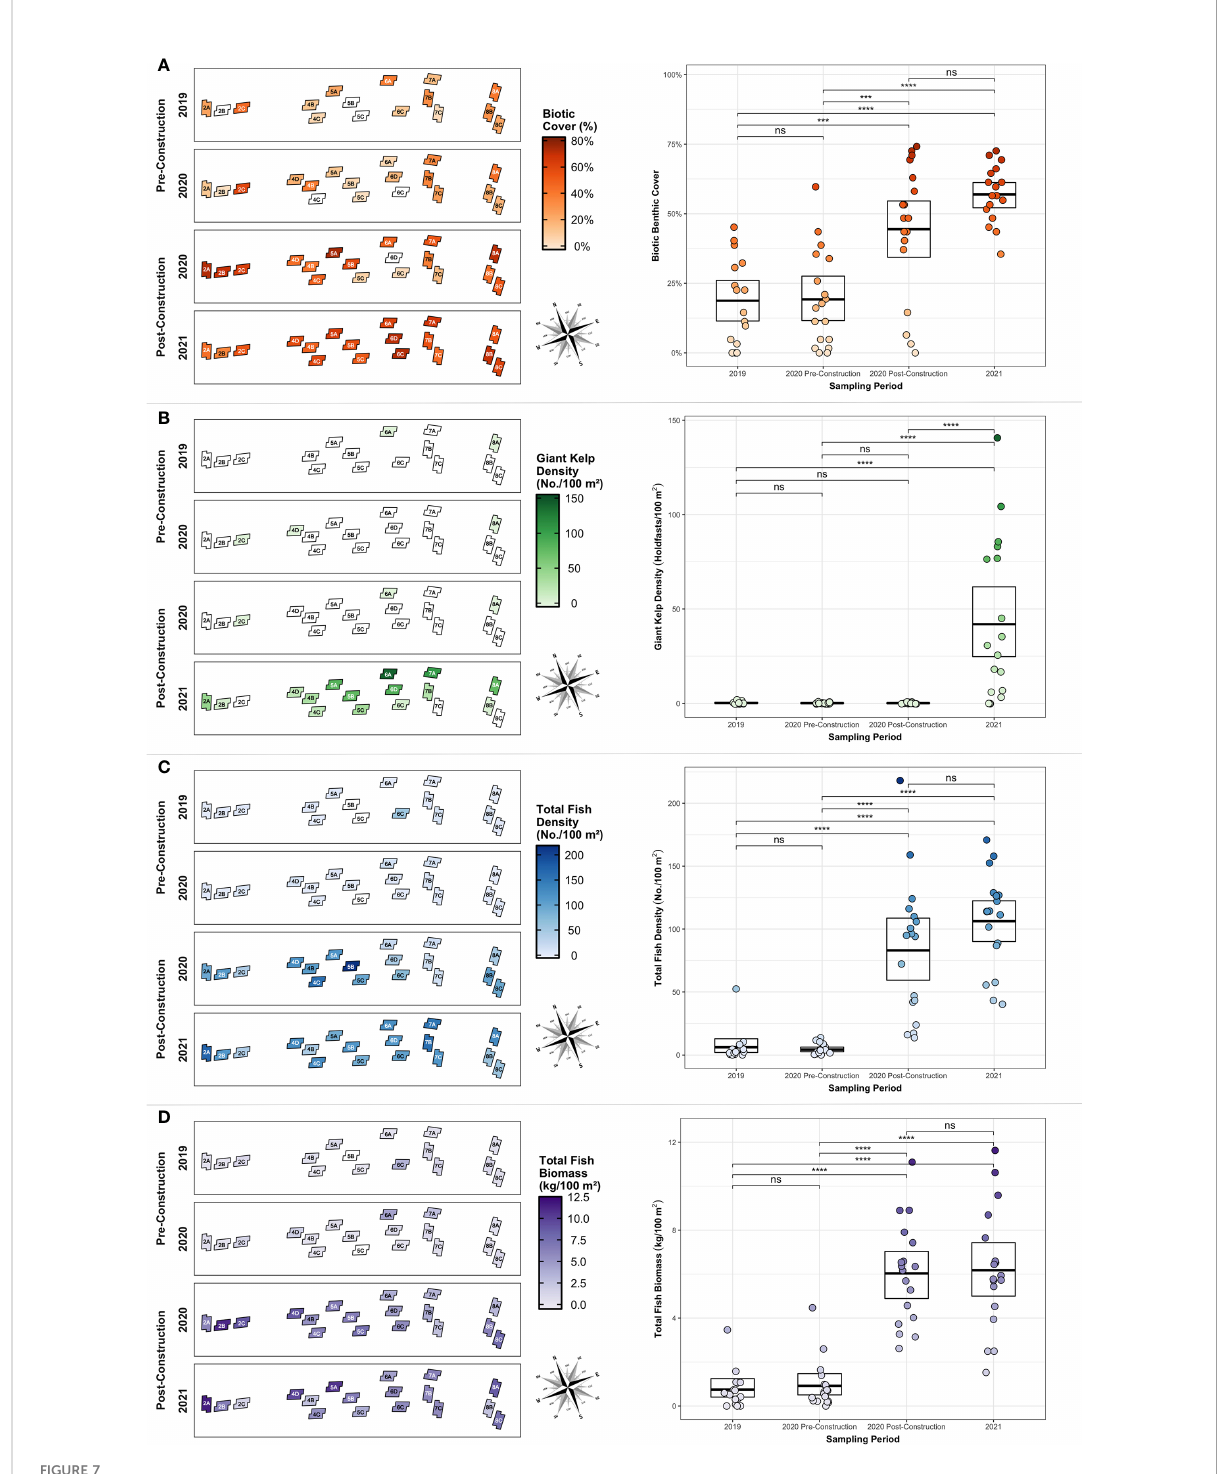
FIGURE 7 (A) Biotic cover, (B) giant kelp holdfast density, (C) total fi sh density, and (D) total fi sh biomass for each sampling period displayed geographically (left) and statistically (right). Notations above brackets indicates signi fi cance level between bracketed sampling periods; ‘ ns ’ , non-signi fi cant ( p > 0.05), *** = p < 0.01, **** = p <